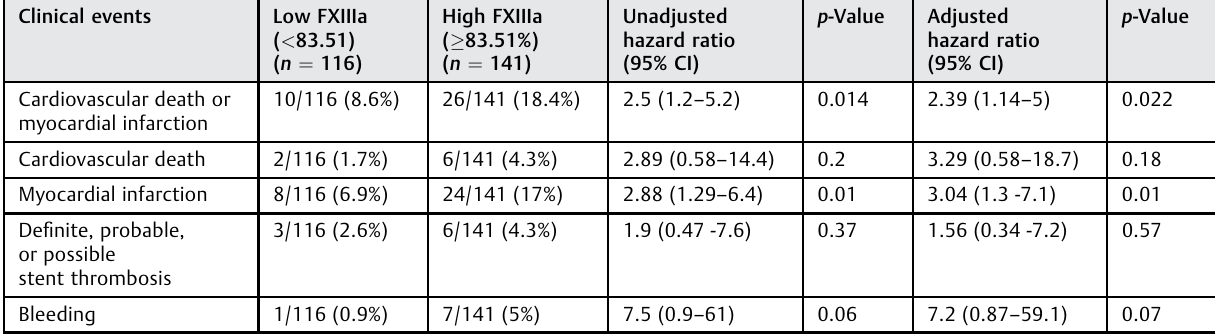
Table 5 Unadjusted and adjusted hazard ratio for clinical outcomes associated with high and low FXIIIa in Cox regression analysis Clinical events